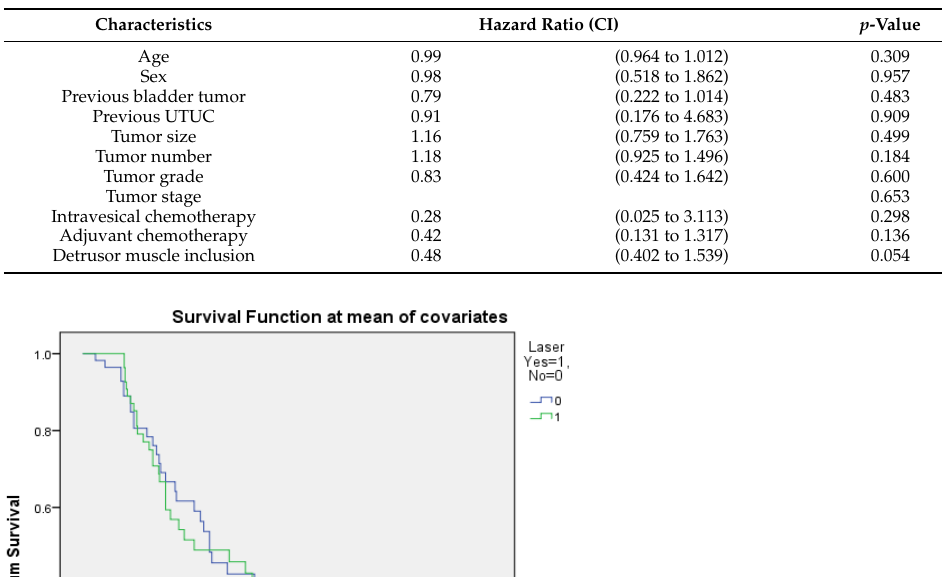
Table 3. Cox-regression analysis of recurrence-free-survival.